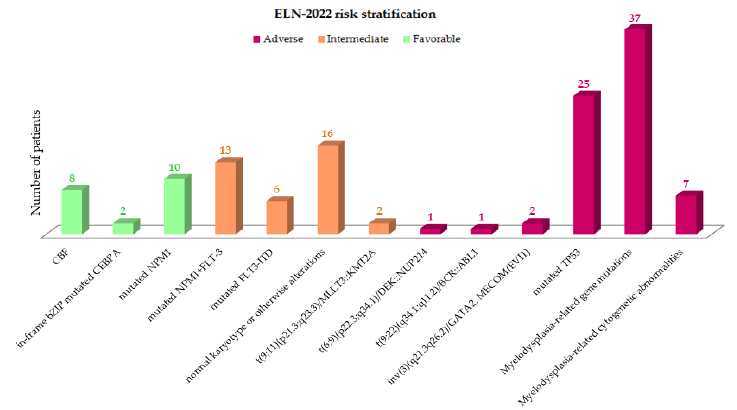
Figure 1. Genetic entities defining in the ELN2022 risk stratification.